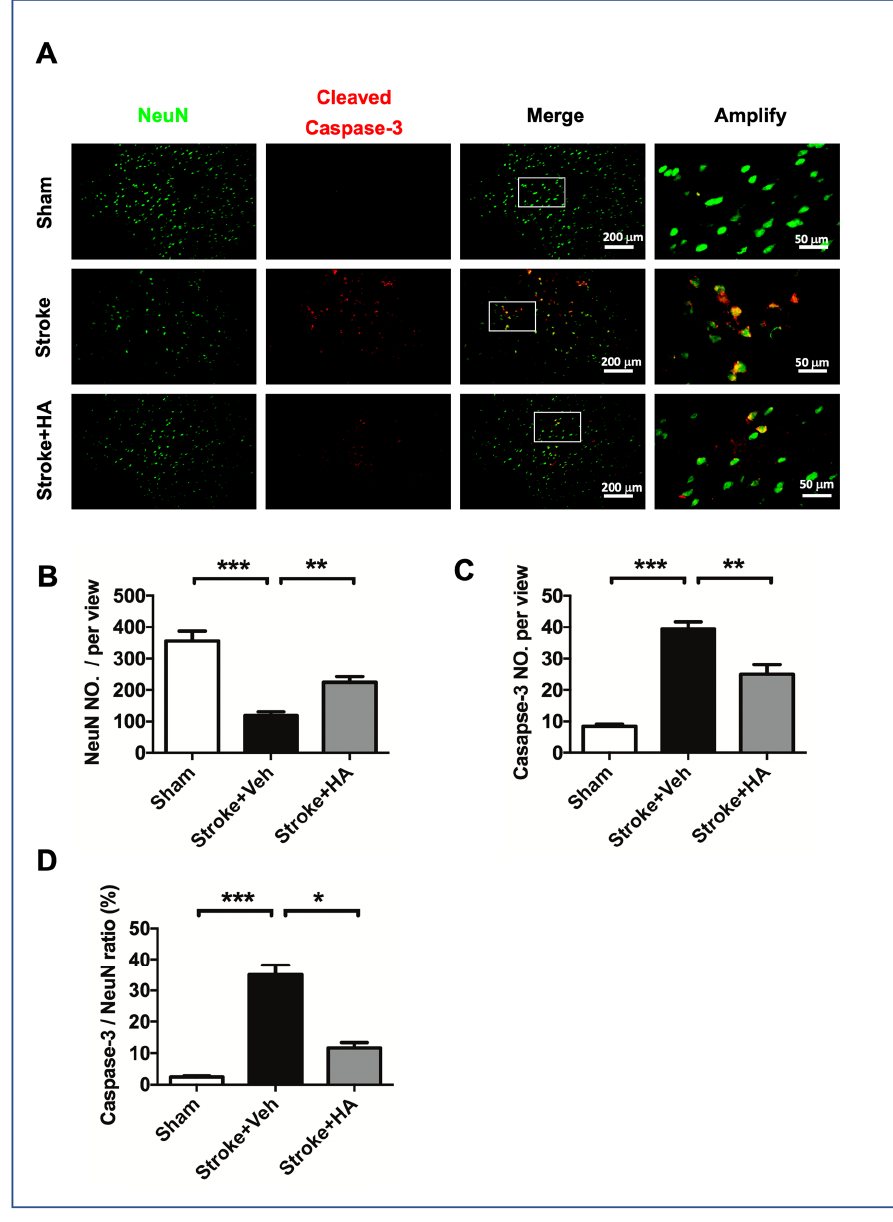
Figure 4 Figure 4. HAtreatmentalleviatedneuronalapoptosisinthebrainofratsafterischemicstroke. ( A )